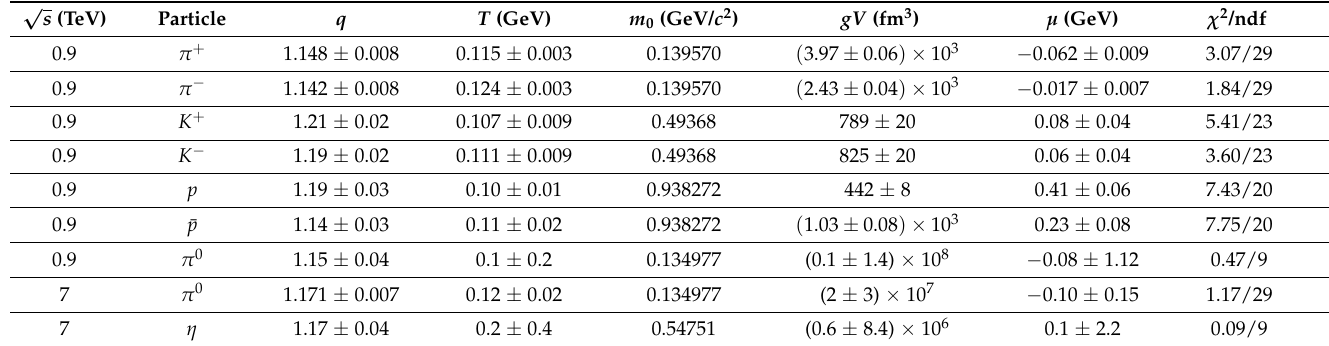
Table 5. Best-fit parameters of the Lorentz invariant cross-section Formula (8). For details, see Table